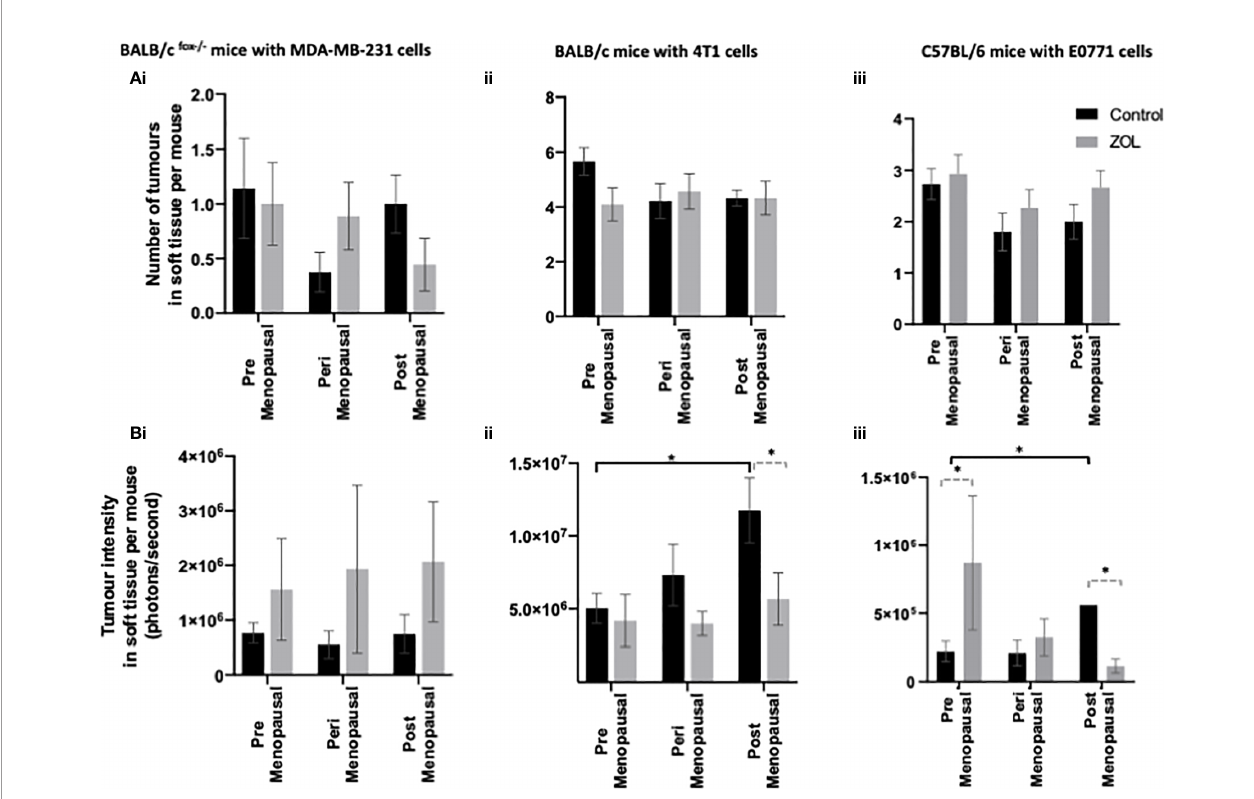
FIGURE 4 | Effects of pre-, post-, and peri-menopausal concentrations of oestradiol ± zoledronic acid on soft tissue metastasis. Histograms show the numbers of overt metastases that form outside the skeleton (A) and the bioluminescence signal in photons per second (P/S) from Luc2-expressing tumour cells outside of bone (B) in BALB/c fox/- mice injected with MDA-MB-231 cells (i), BALB/c mice injected with 4T1 cells (ii), and C57BL/6 mice injected with E0771 cells (iii) (n = 10/group). Cell lines were disseminated directly into the bloodstream of the mouse via intracardiac injection 3, 6, and 7-days after induction of pre-, peri-, or post-menopausal concentrations of oestradiol in BALB/c nude, BALB/c, and C57BL/6, respectively, and 3 days after fi rst injection of zoledronic acid. Zoledronic acid was administered weekly at a dose of 100 m g/kg, and all mice received daily injection of goserelin (40 m g/kg). All data on histograms are represented as mean ± SD; *p <